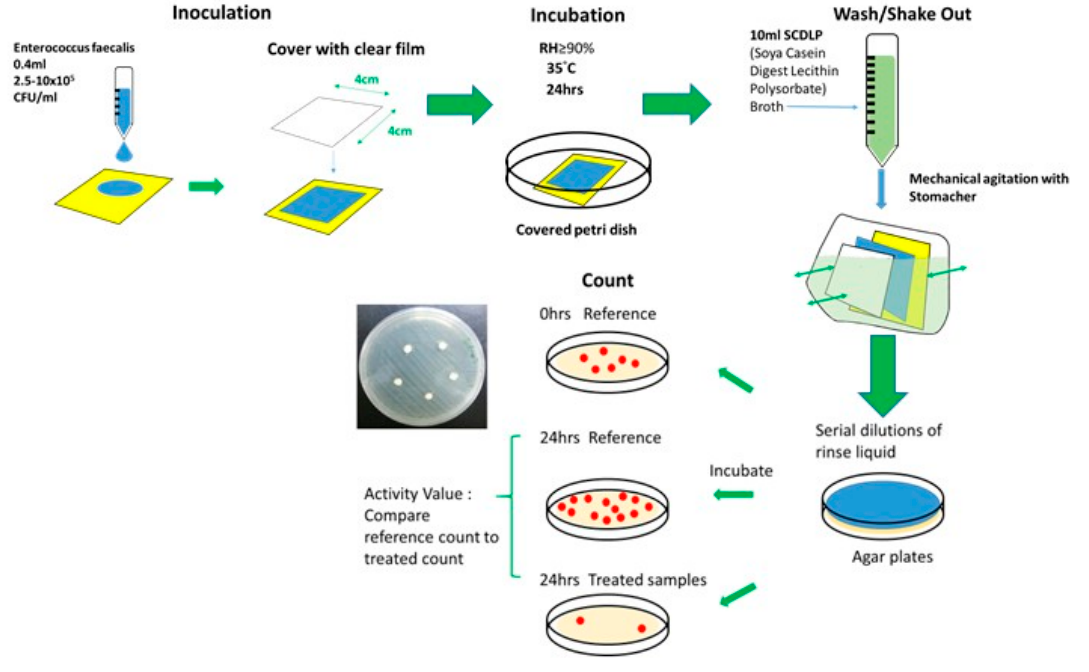
Figure 4. The process of antibacterial evaluation.